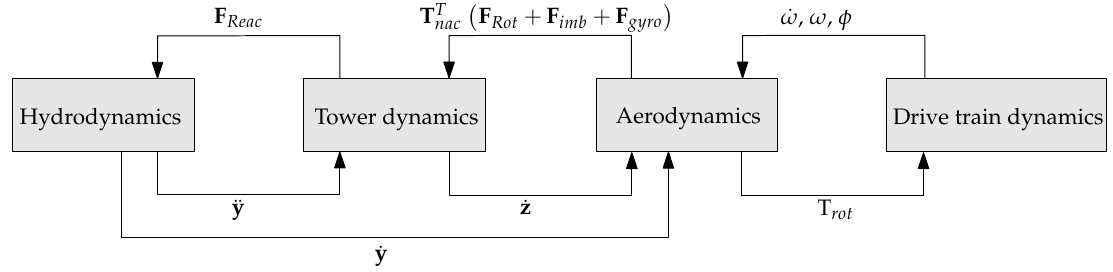
Figure 2. Visualization of the coupling terms between the different